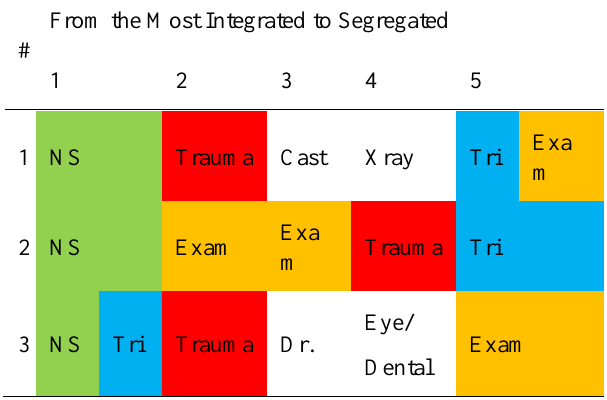
Order of the most integrated spaces based on space syntax analysis From the Most Integrated to